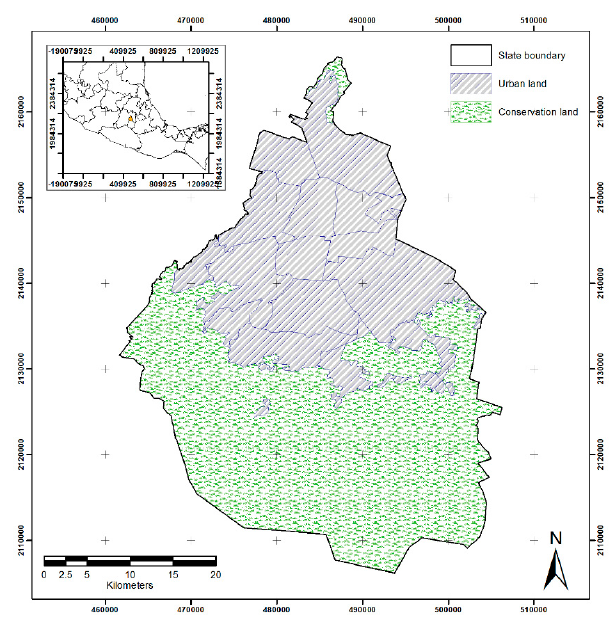
Figure 1. Study area delimited by Mexico City’s urban